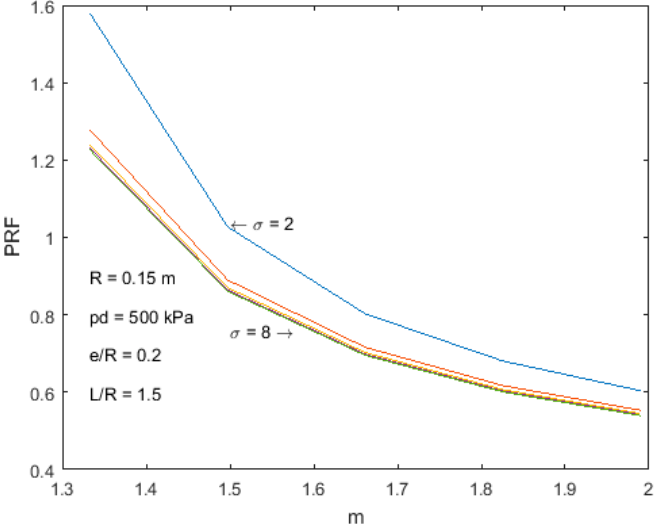
Figure 15. Power recovery factor ( PRF ) versus the polytropic exponent ( m) , for different expansion ratios σ , σ = 2.0 (blue line), σ = 3.5 (red line), σ = 5.0 (orange line), σ = 6.5 (violet line), σ = 8.0 (green line).